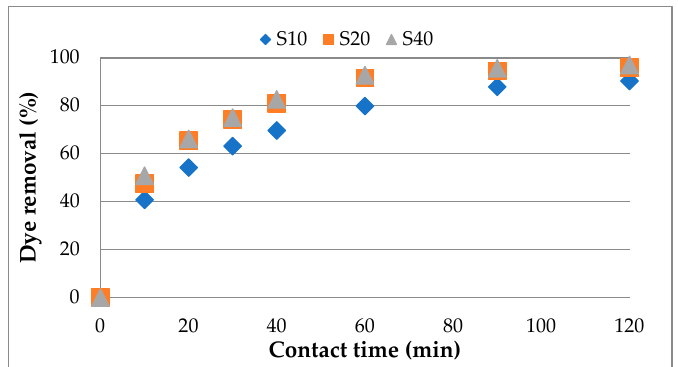
Figure 5. Dye removal vs. contact time of rice husk treated with 10, 20 and 40 g/L solution of sodium hydroxide (NaOH) at 90 °C for 30 min (adsorption conditions are 0.1 g/L Congo red, 25 °C, 10 g/L rice husk).